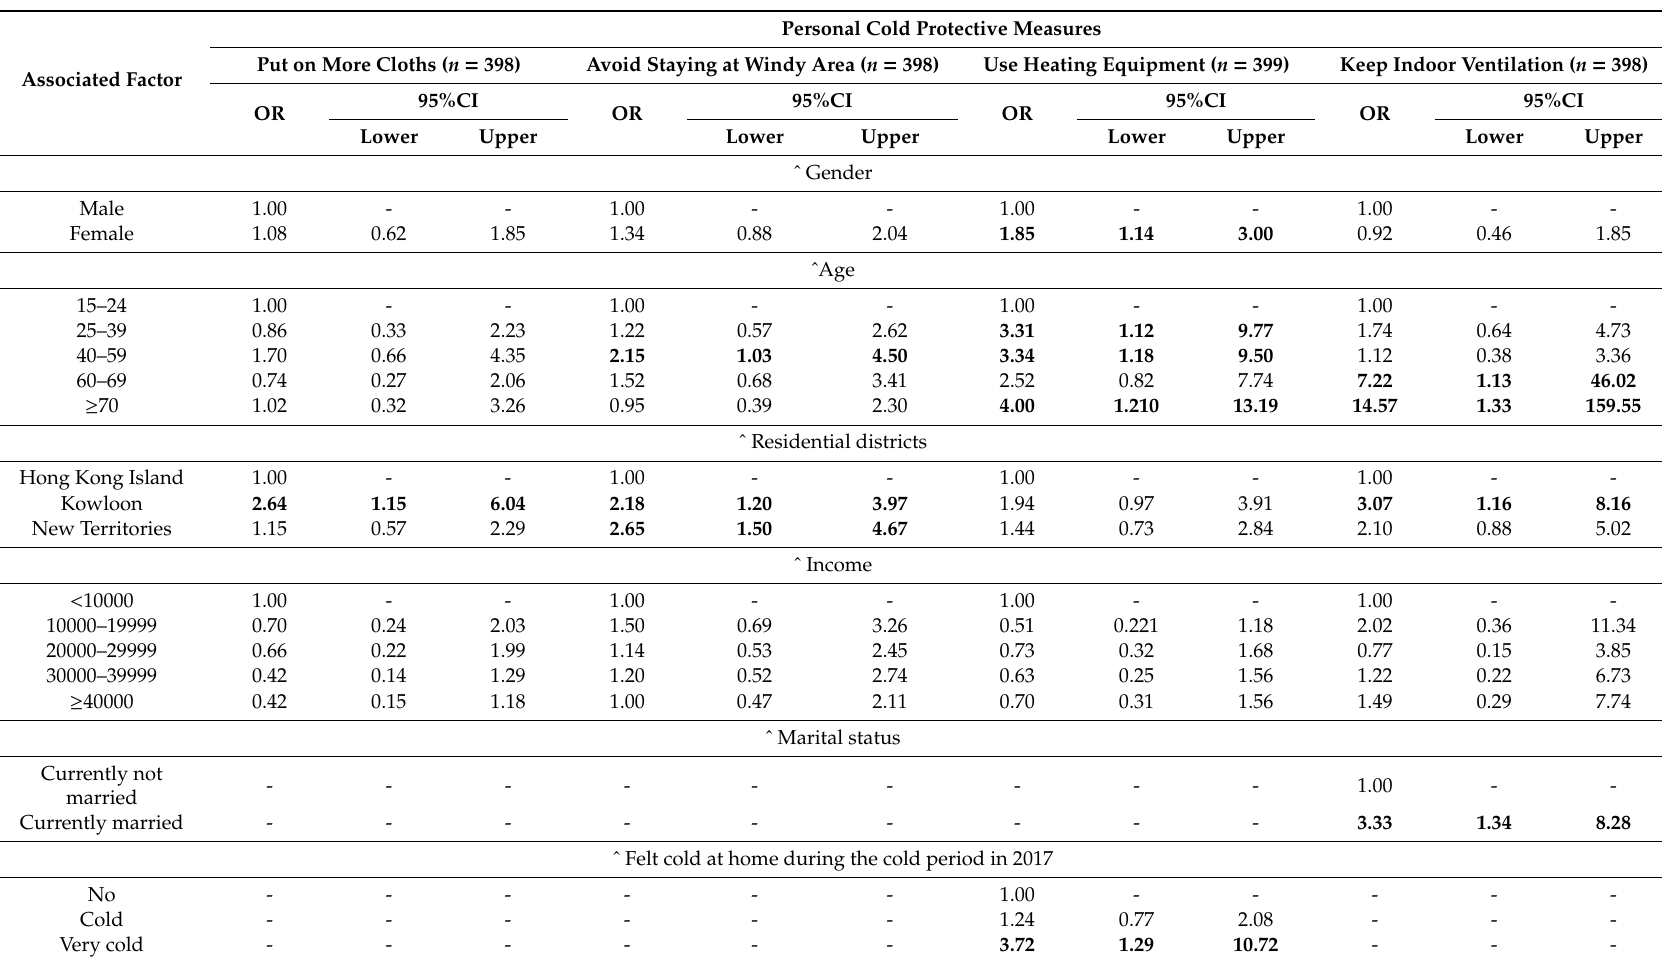
Table 4. Adjusted Odds-ratio (OR) of associated factors of personal cold protective behaviours in 2017 cold wave using multiple logistic regression.